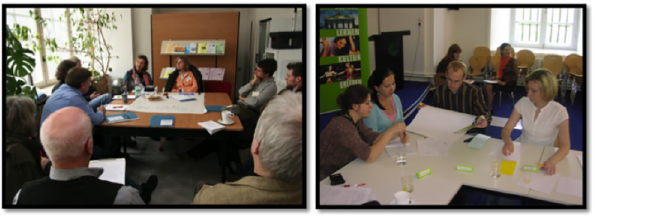
Fig 1. Example of a stimuli used in Study 1.